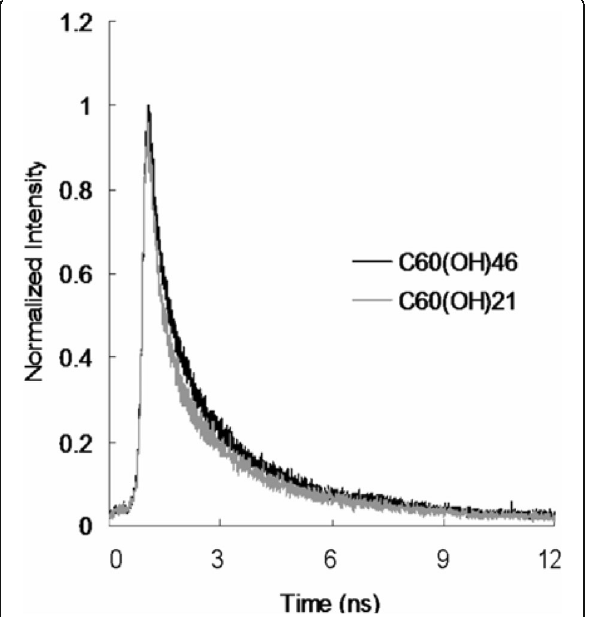
Fig. 7 Time-resolved room-temperature PL decay profiles of material (98.56 nJ pixel − 1 ). Excitation wavelength, 760 nm. Delivered dose, OD 600 ~ 0.05 of E. coli and 3 μ g mL − 1 materials. Data are presented